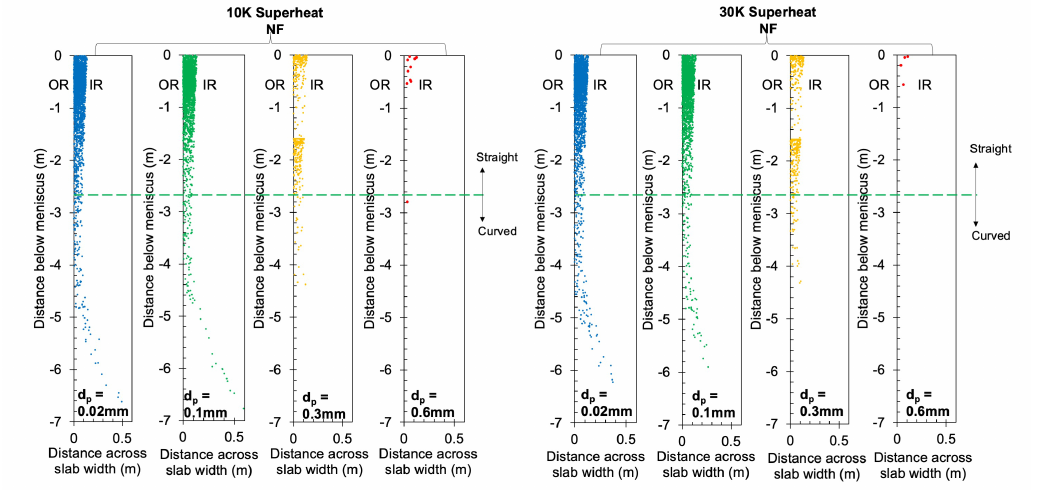
Figure 21. Capture locations on the narrow face (NF) of the selected bubble sizes—side